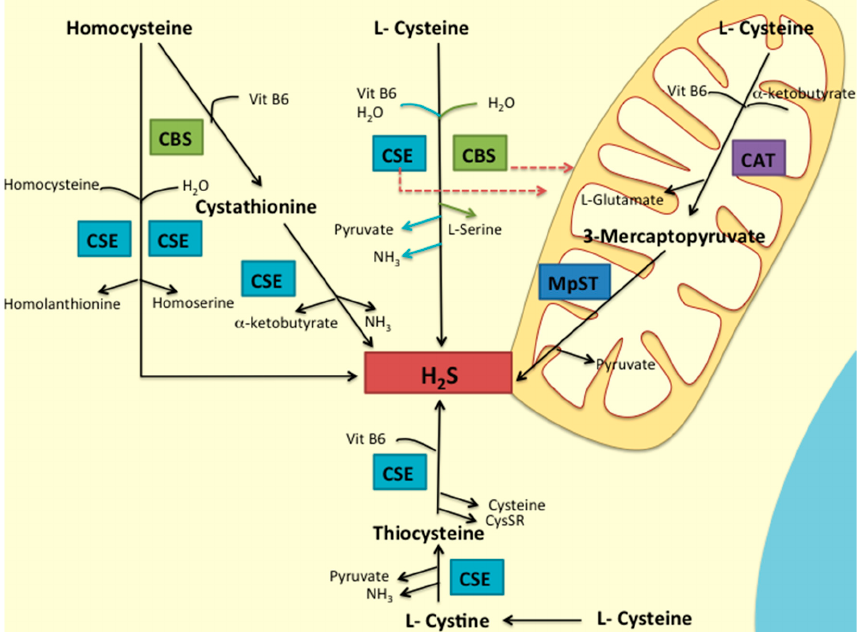
Figure 2. Pathways of H 2 S production in mammalian cells. H 2 S is synthesized from homocysteine or cysteine by the enzymes CBS and CSE, or by the sequential activity of CAT and MpST. In physiological conditions, CBS and CSE produce cytosolic H 2 S, whereas, in case of cellular stress, the enzymes can be relocated to the mitochondria, supporting CAT/MpST activities. Adapted from Wang [92] and Olson et al. [95].